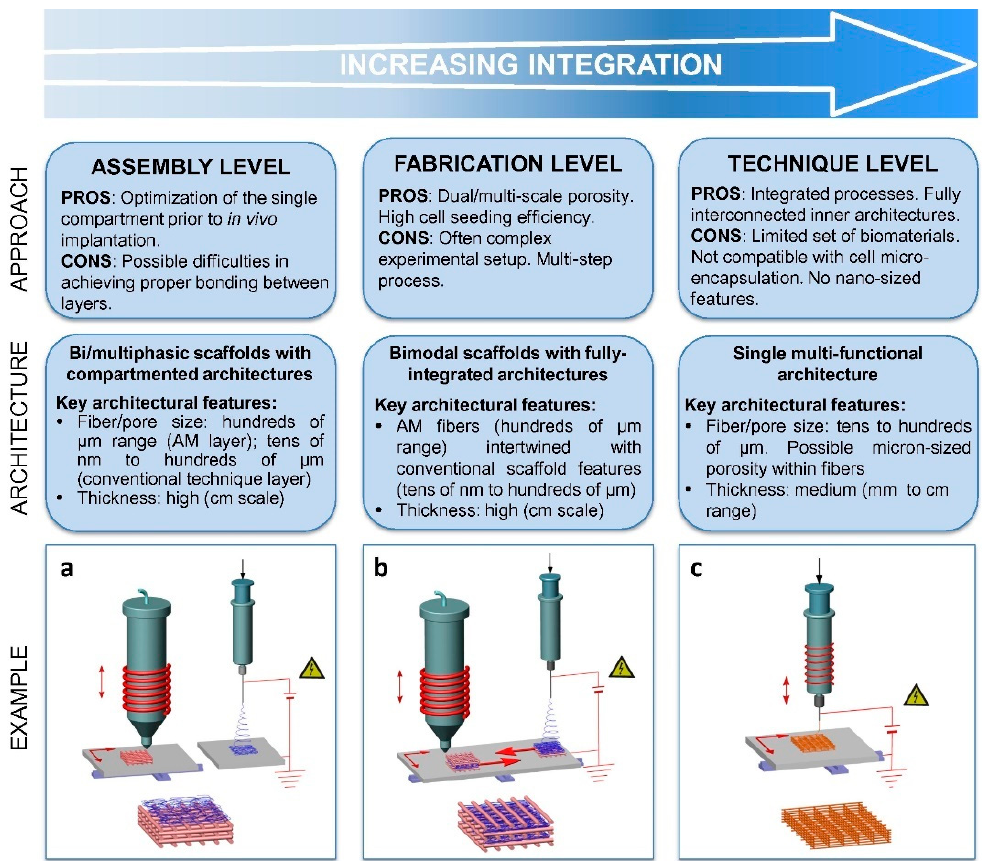
Figure 2. Classification of combined additive manufacturing techniques with details on advantages and limitations and key scaffold architectural characteristics for each approach. A combination of AM with electrospinning (ES) has been chosen as a representative example for the illustration of manufacturing equipment and obtained microstructures. In the drawings: ( a ) bonding between AM and ES scaffolds (assembly level); ( b ) deposition of AM and ES layers within a single scaffold (fabrication level); and ( c ) melt electrospinning direct writing as a de novo, single technique integrating the working principles of the two processes (technique level). Reproduced with permission from S. M. Giannitelli et al., Acta Biomaterialia; published by Elsevier, 2015 [67].